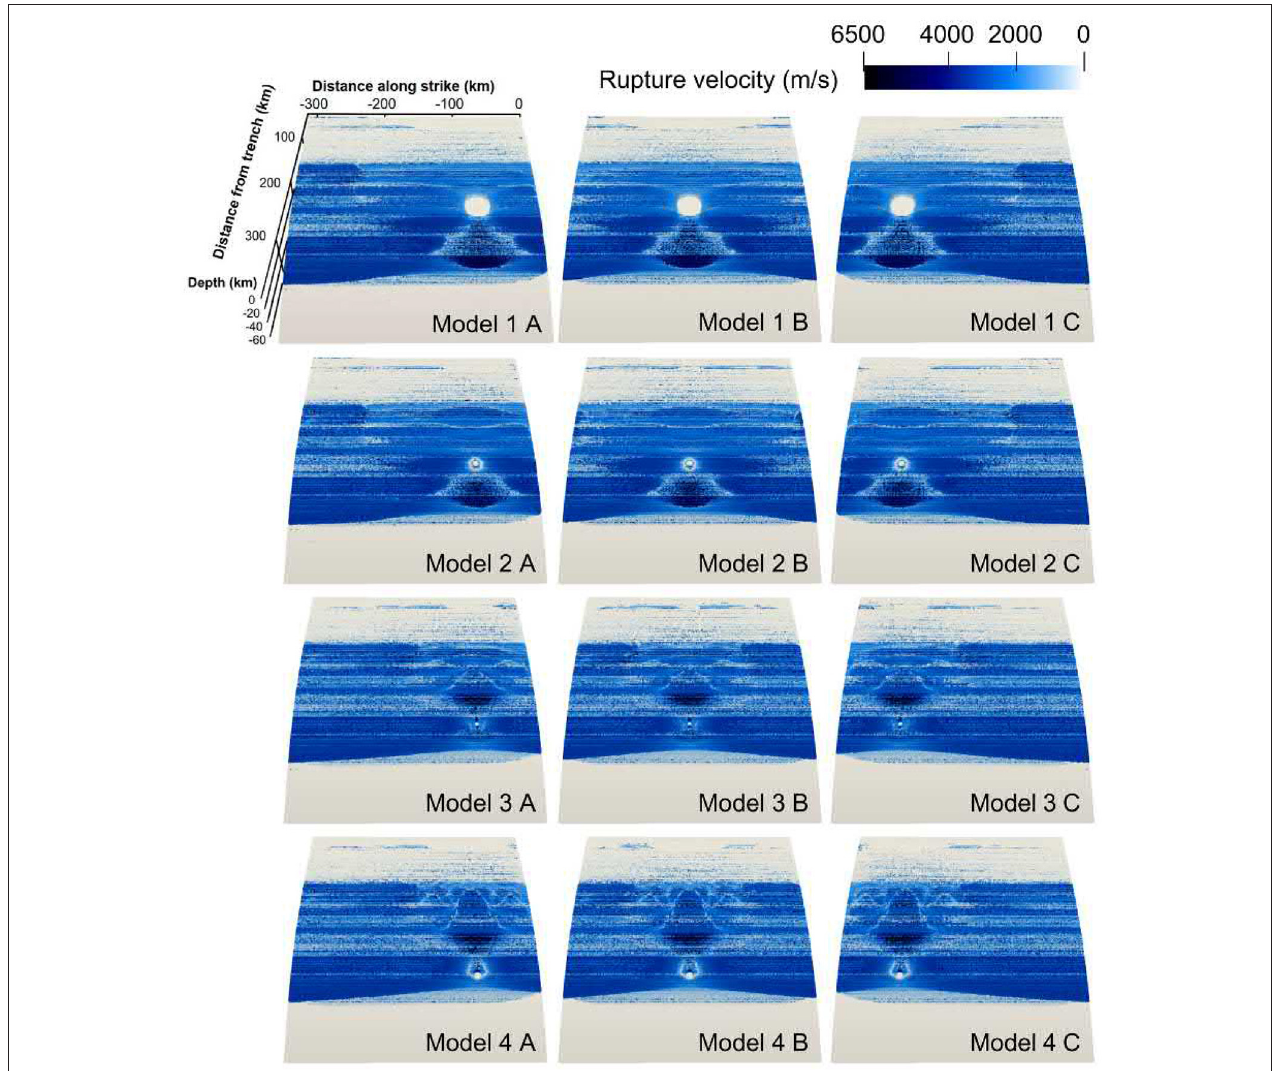
FIGURE 5 | Rupture velocity for 12 dynamic rupture simulations with varying hypocenter locations. Note the difference in nucleation radii according to Table 1 . Most parts of the fault rupture at speeds around 3,000 m/s. Much lower velocities are visible in the shallower fault part. Supershear rupture is visible as dark blue areas in downdip direction for nucleation locations at a depth of 25 and 30 km and in updip direction for nucleation depths of 40 and 45 km. The rupture velocity is very inhomogeneous due to the complex and heterogeneous material properties on the